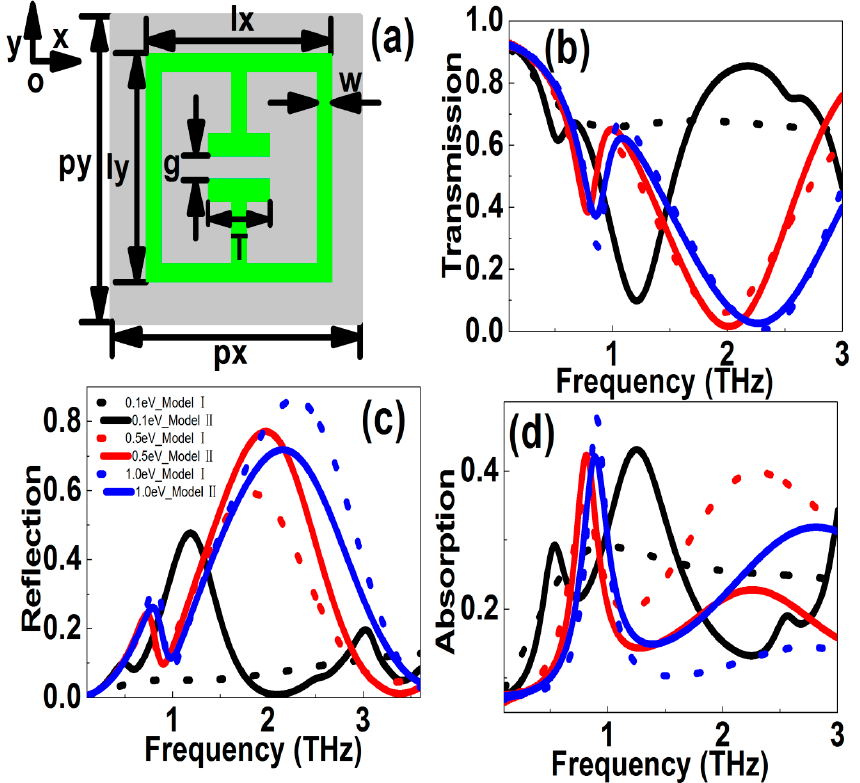
Figure 2. ( a ) Sketches of graphene eSRRs patterns. ( b – d ) The transmission, reflection, absorption resonant curves versus frequency at di ff erent Fermi levels, respectively. The polarization was along the y direction. The Fermi levels were 0.1, 0.2, 0.3, 0.5, 0.8, and 1.0 eV,